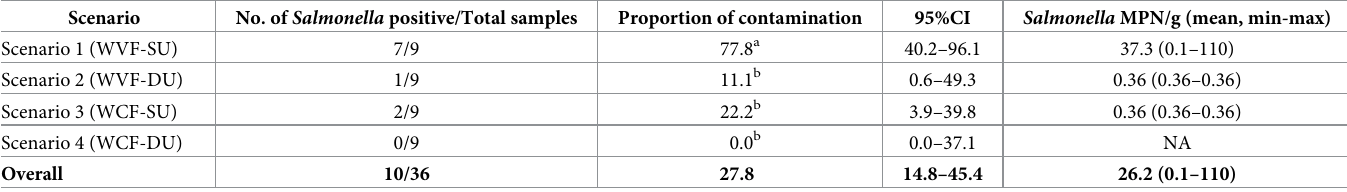
Table 4. Contamination of Salmonella in ready-to-eat chicken salad during preparation and handling in four different experiment scenarios. Scenario